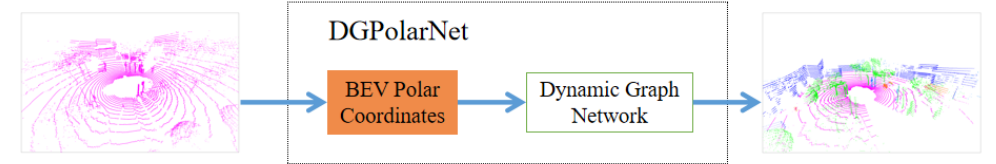
Figure 2. DGPolarNet framework for semantic segmentation from LiDAR point clouds.